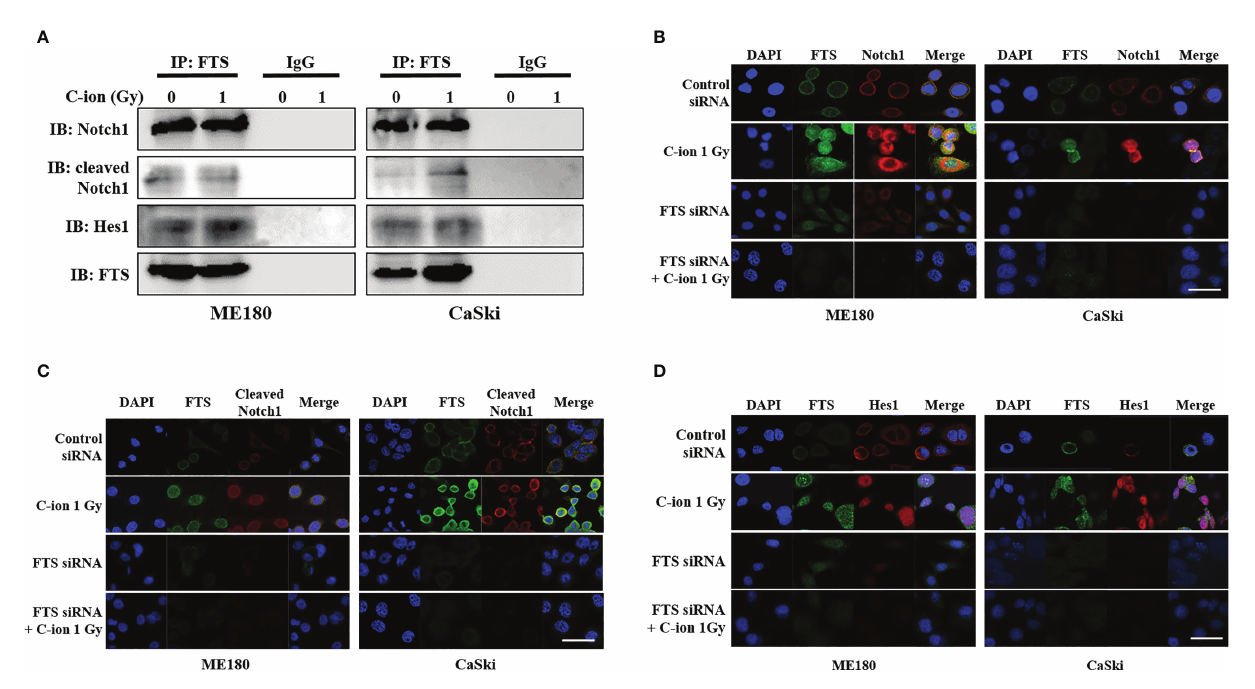
FIGURE 4 | Immunoprecipitation assay and immuno fl uorescence show the interaction between FTS and Notch1/cleaved Notch1/Hes1 in ME180 and CaSki cells. Cells were irradiated with 0 or 1 Gy C-ion and lysed after 24 h. Immunoprecipitation was performed with whole cell lysates using FTS antibody. IgG was used as negative control (A) . For immuno fl uorescence, the cells were grown in chamber slides. Cells were irradiated with 0 or 1 Gy C-ion. FTS was detected with Alexa Fluor 488 (green), whereas Notch1, cleaved Notch1 and Hes1 were detected using Alexa Fluor 594 (red), 24 h post-irradiation (B – D) . The images shown in this fi gure are the representatives of at least three independent experiments. White bar in each panel corresponds to 10